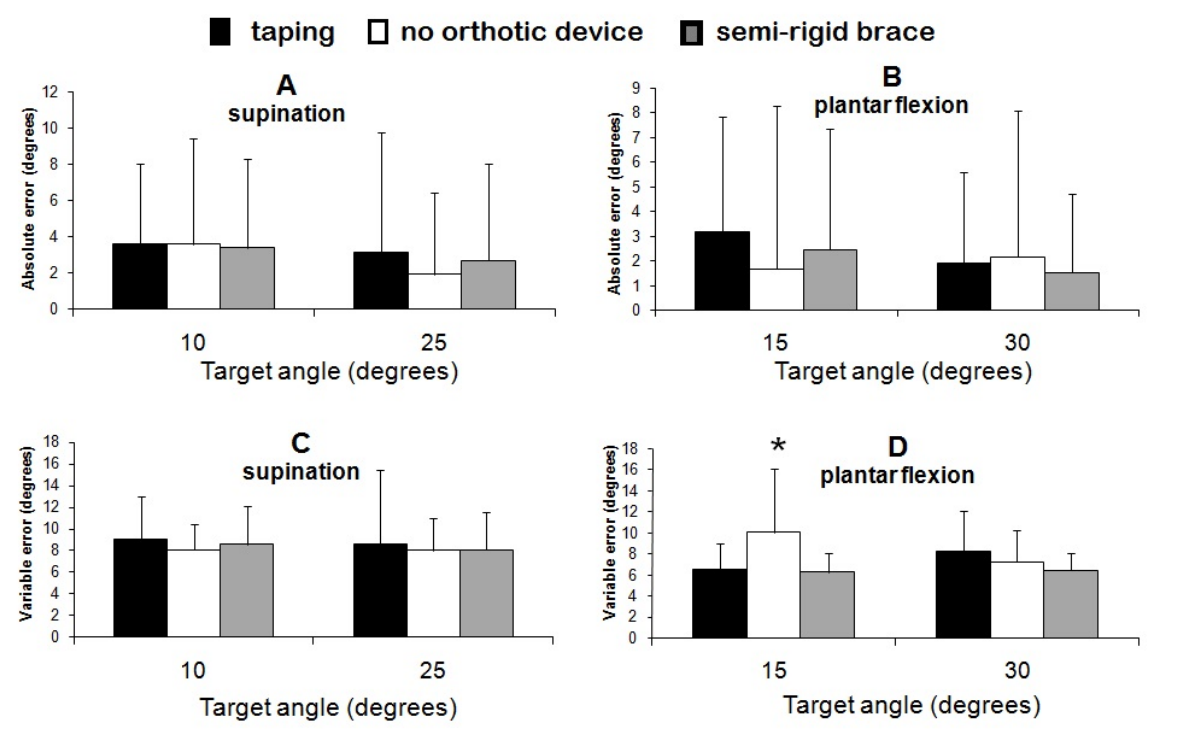
Figure 4. Mean (+ SD) Absolute error (AE) and variable error (VE) obtained during supination at 10 o and 25 o and during plantar flexion at 15 o and 30 o . *Significantly higher than in the taping and semi-rigid ankle brace conditions ( n = 16; p =